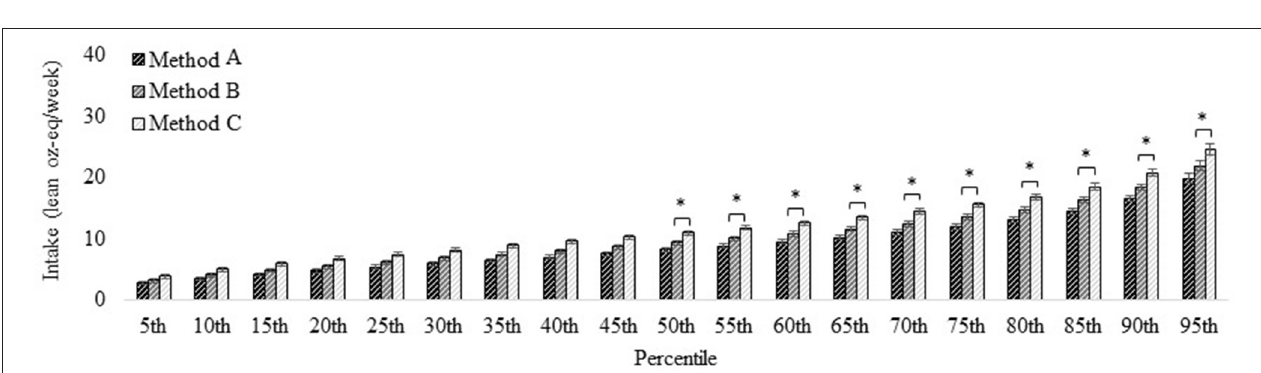
FIGURE 2 | Distribution of red meat intake for the U.S. population aged ≥ 2 years estimated via different methods. Method 1: Unprocessed red meat, includes beef, veal, pork, lamb, and game meat; excludes organ meat and processed meat. Method 2 (reference): Total red meat, includes unprocessed red meat and processed red meat. Method 3: Red and processed meat, includes unprocessed red meat, processed red meat, and processed poultry. Method 4: Red and processed meat, additionally including chicken patties, nuggets, and tenders. See Figure 1 for further descriptions of each method. Results are shown as mean ± SEM within each percentile estimated via the NCI Method for usual dietary intakes. *Difference from Method 1 estimate (effect size) is ≥ 3.0 oz-eq per week; **difference from Method 1estimate is ≥ 6.0 oz-eq servings per week; ***difference from Method 1 estimate is ≥ 9.0 oz-eq per week. Data source: US Centers for Disease Control and Prevention/National Center for Health Statistics, NHANES 2015-2018, day 1 and 2 dietary recall data.